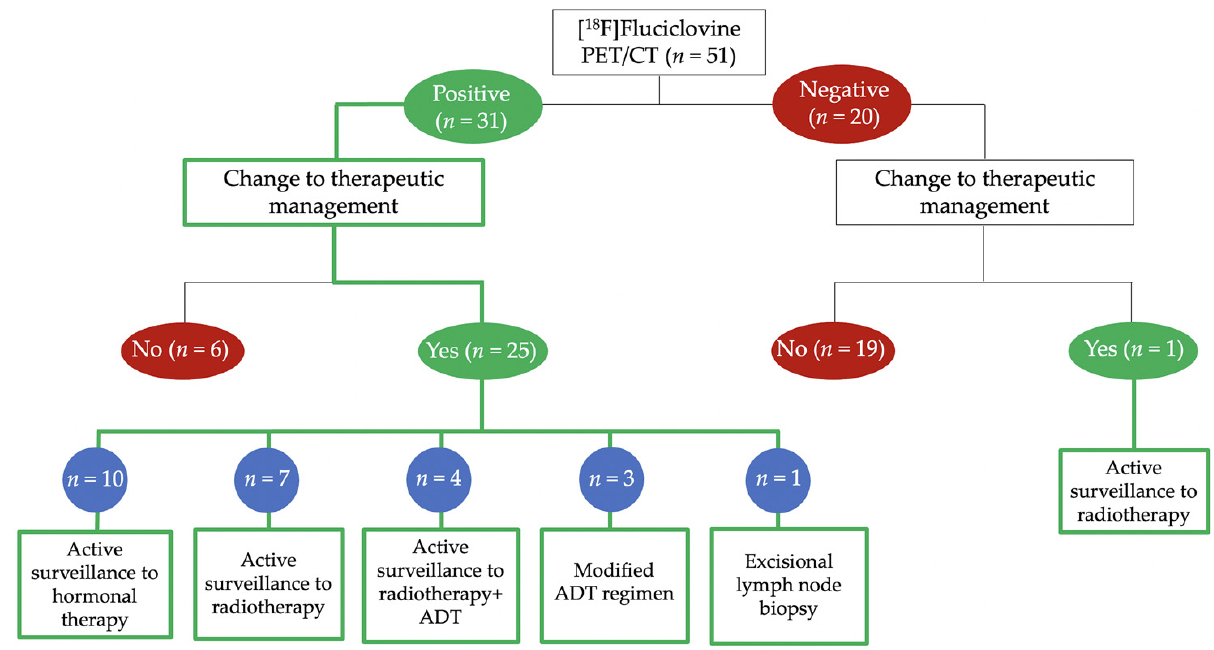
Figure 4. Impact of [ 18 F]Fluciclovine PET/CT scan on clinical management of the PCa patients. ADT, androgen deprivation therapy.